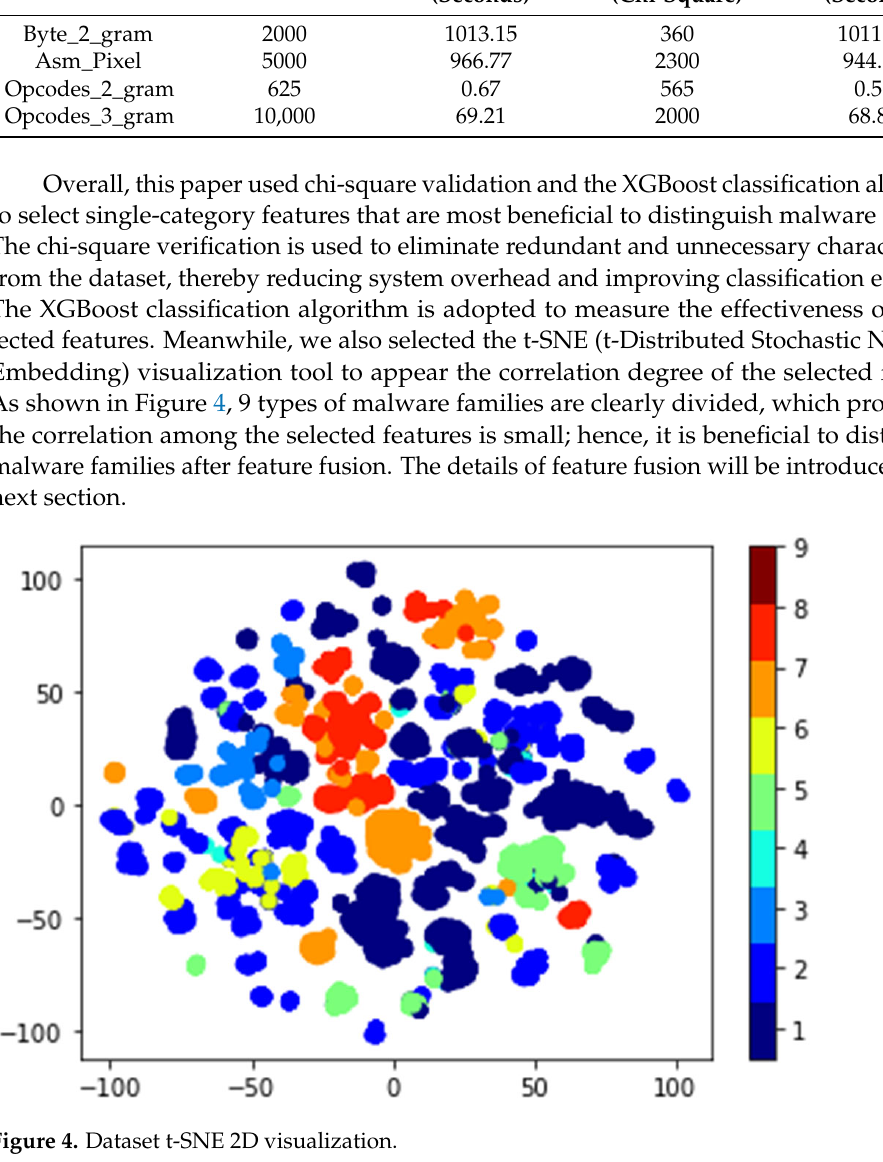
Table 4. Chi-square verification for feature selection.